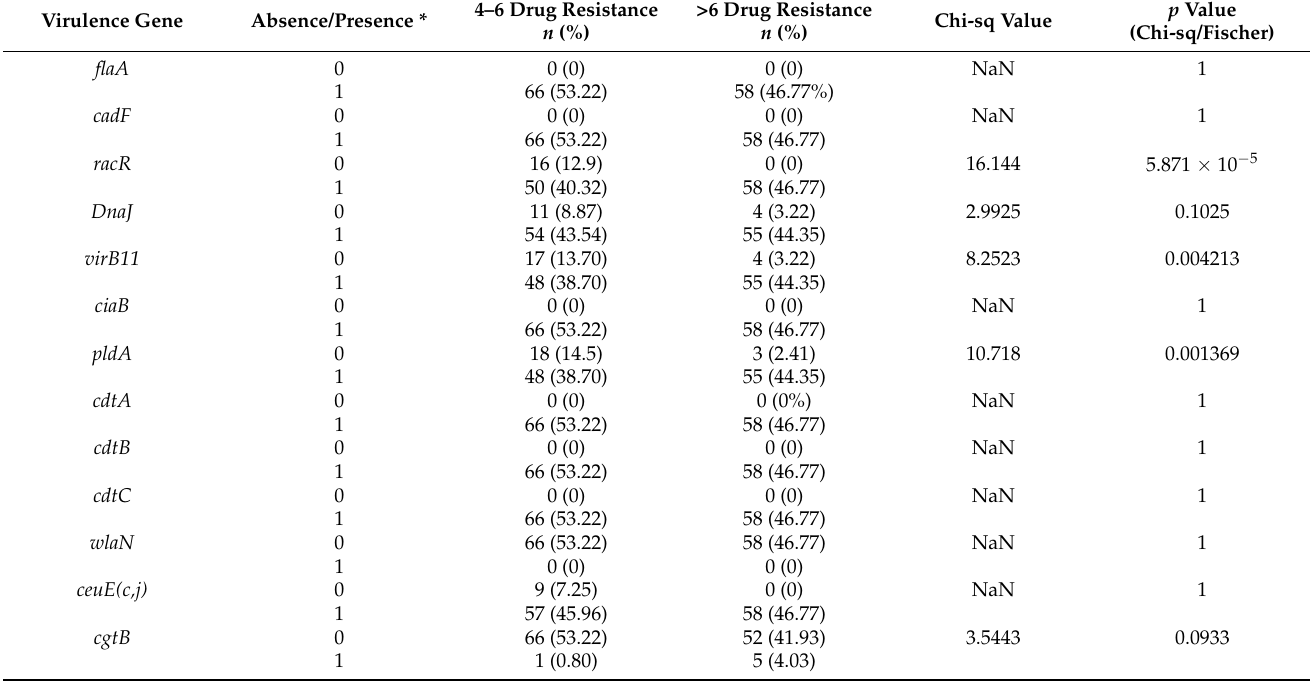
Table 2. Associations between virulence genes and multidrug resistance in C. jejuni isolates ( n =